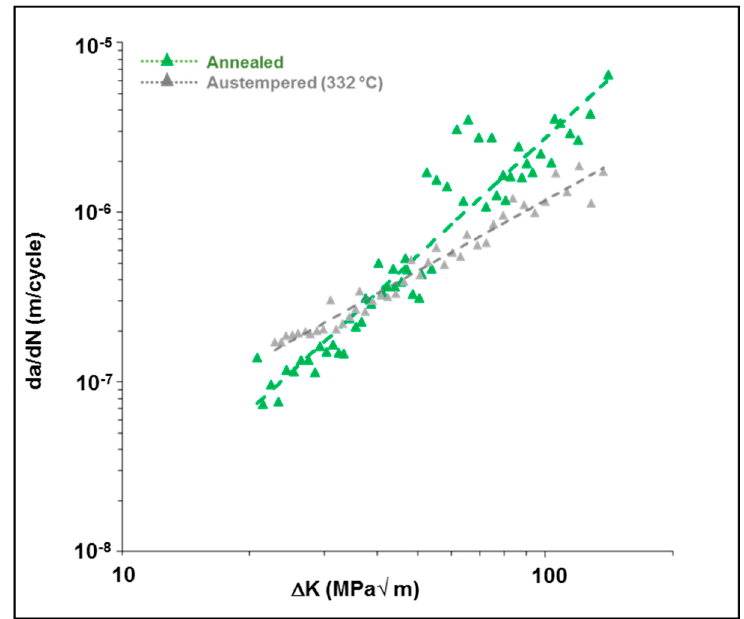
Figure 10. The Effect of Austempering on the Fatigue Crack Growth Rate of the 4140 Steel Hydrogen-Charged for 200 h.